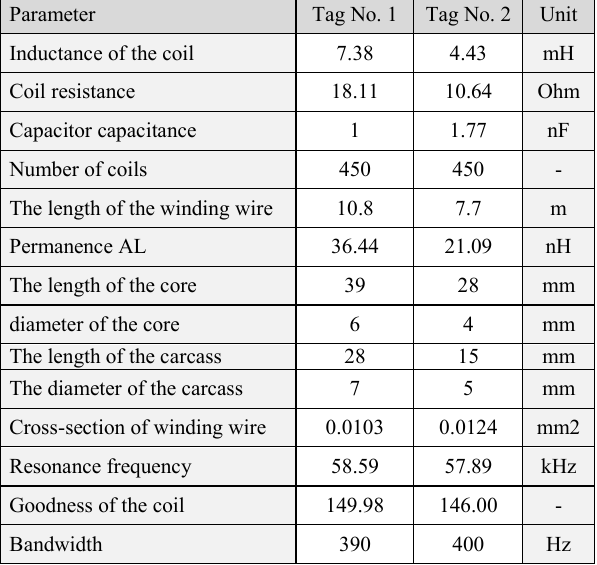
Table 1. Parameters of tags for the magnetacoustic system.